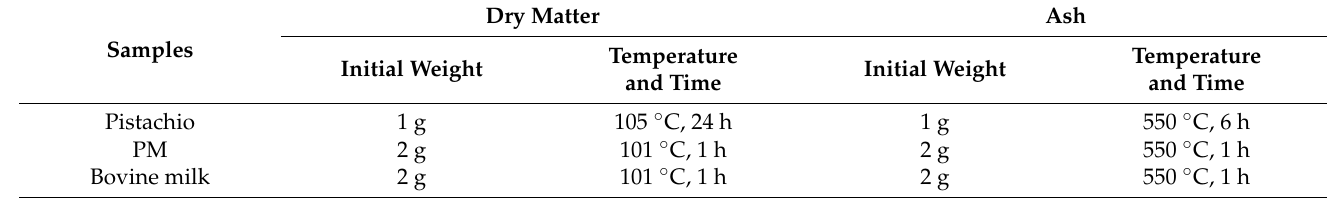
Table 1. The conditions for dry matter and ash content measurements in pistachio, PM, and bovine milk.